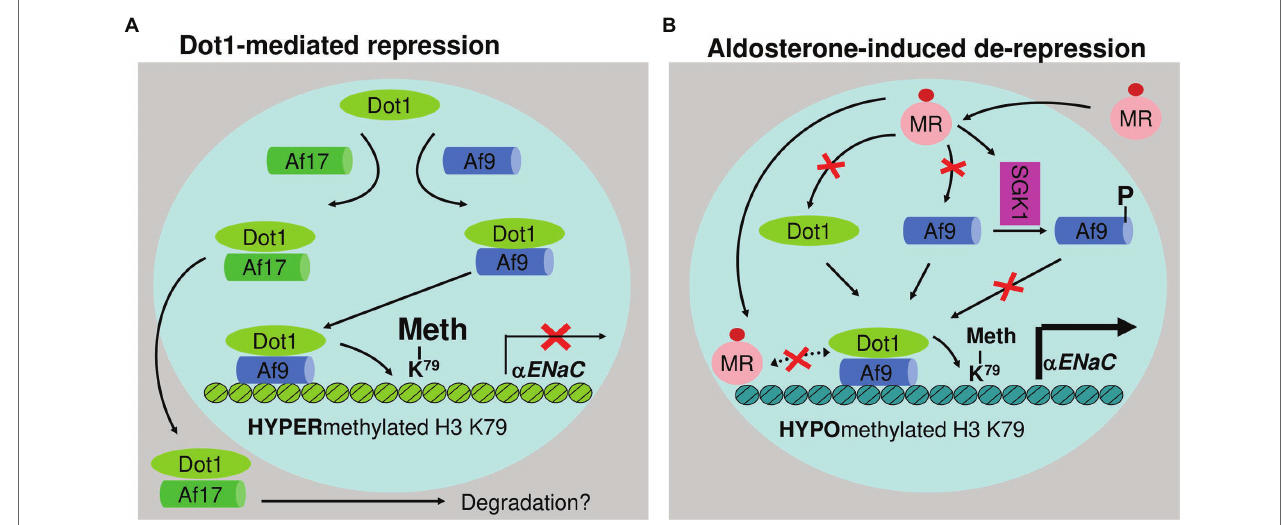
FIGURE 5 | Epigenetic control of α ENaC transcription. Under basal conditions (A) , Af9 recruits Dot1a to form a nuclear complex, which indirectly or directly through Af9 DNA-binding activity binds specific sites of the α ENaC promoter, leading to hypermethylation of histone H3 K79 and repression of α ENaC transcription. Af17 relieves the repression by competing with Af9 for binding Dot1a and promoting Dot1a redistribution from the nucleus to cytoplasm. In the presence of aldosterone (B) , α ENaC transcription is induced by a variety of mechanisms. Through the classical action, aldosterone binds and activates the mineralocorticoid receptor to bind the glucocorticoid response element in the α ENaC promoter and transactivate α ENaC. In parallel, aldosterone releases Dot1a–Af9-mediated repression by reducing the formation of the complex through three mechanisms: downregulating Dot1a and Af9 expression presumably via nuclear receptor- dependent or -independent (not shown) mechanisms, decreasing the Dot1a–Af9 interaction via SGK1-mediated phosphorylation of Af9 at Ser435, and counterbalancing Dot1a–Af9 complex by activating MR to compete for binding Af9. These actions collectively result in histone H3 K79 hypomethylation at specific subregions of the α ENaC promoter. In all cases, Af9-free Dot1a binds DNA nonspecifically and catalyzes histone H3 K79 methylation throughout the genome under basal conditions (not shown). Revised from Chen et al. (2015). Dot1a: disruptor of telomeric silencing 1a. Meth: methylation. α ENaC: α epithelial sodium channel. NR: nuclear hormone receptor. SGK1: serum glucocorticoid-induced kinase